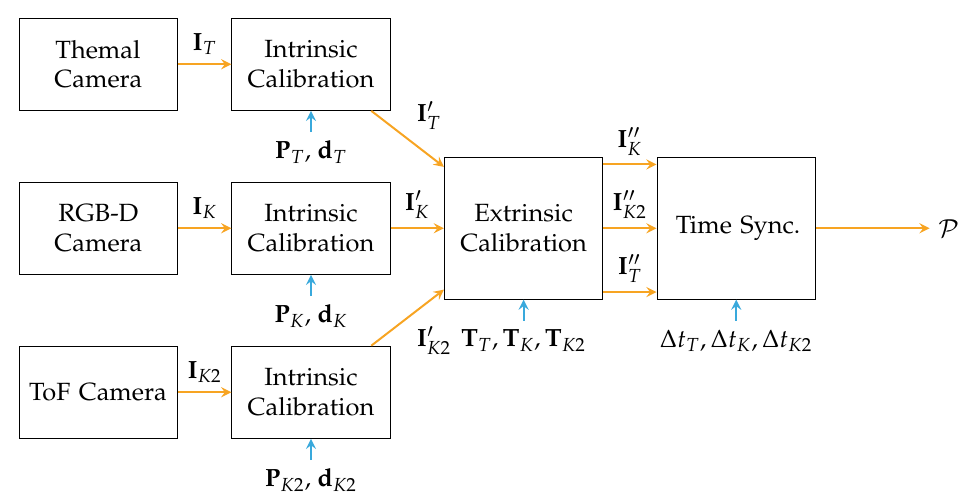
Figure 4. Process of sensor calibration: First, all projective sensors are calibrated intrinsically to remove distortions from the image and to obtain the projection matrix for each sensor P T , P K and P K 2 . Furthermore, the coefficients for distortions d = ( k 1 k 2 k 3 p 1 p 2 ) are necessary for rectification. The vector contains the parameters for radial distortion ( k 1 , k 2 , k 3 ), as well as the parameters for tangential distortion ( p 1 , p 2 ) [35]. Second, the sensors are calibrated extrinsically, estimating the transformations between the sensors T . The calibrated images are noted by I (cid:48) I (cid:48) , and I (cid:48) . Finally, the data from the sensors are synchronized in time based on ∆ t T , ∆ t K , ∆ t K 2 . K K 2 The synchronized images are noted by I (cid:48)(cid:48) , I (cid:48)(cid:48) , and I (cid:48)(cid:48) . After this process of calibration, sensor fusion K K 2 T can be applied and data is converted towards a Cartesian point cloud P ∈ R 3 .